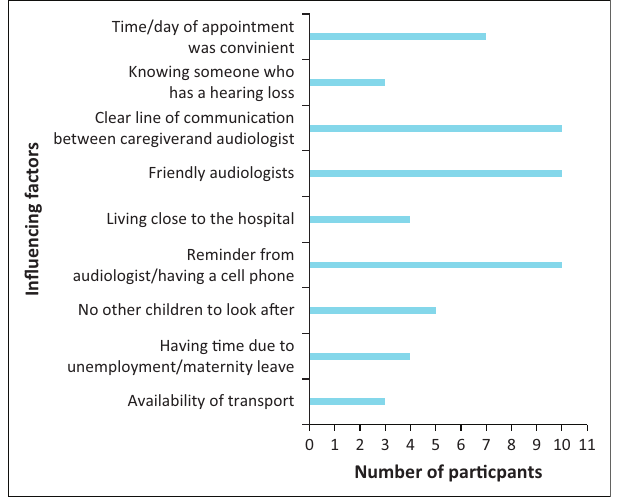
FIGURE 1: Positive factors influencing